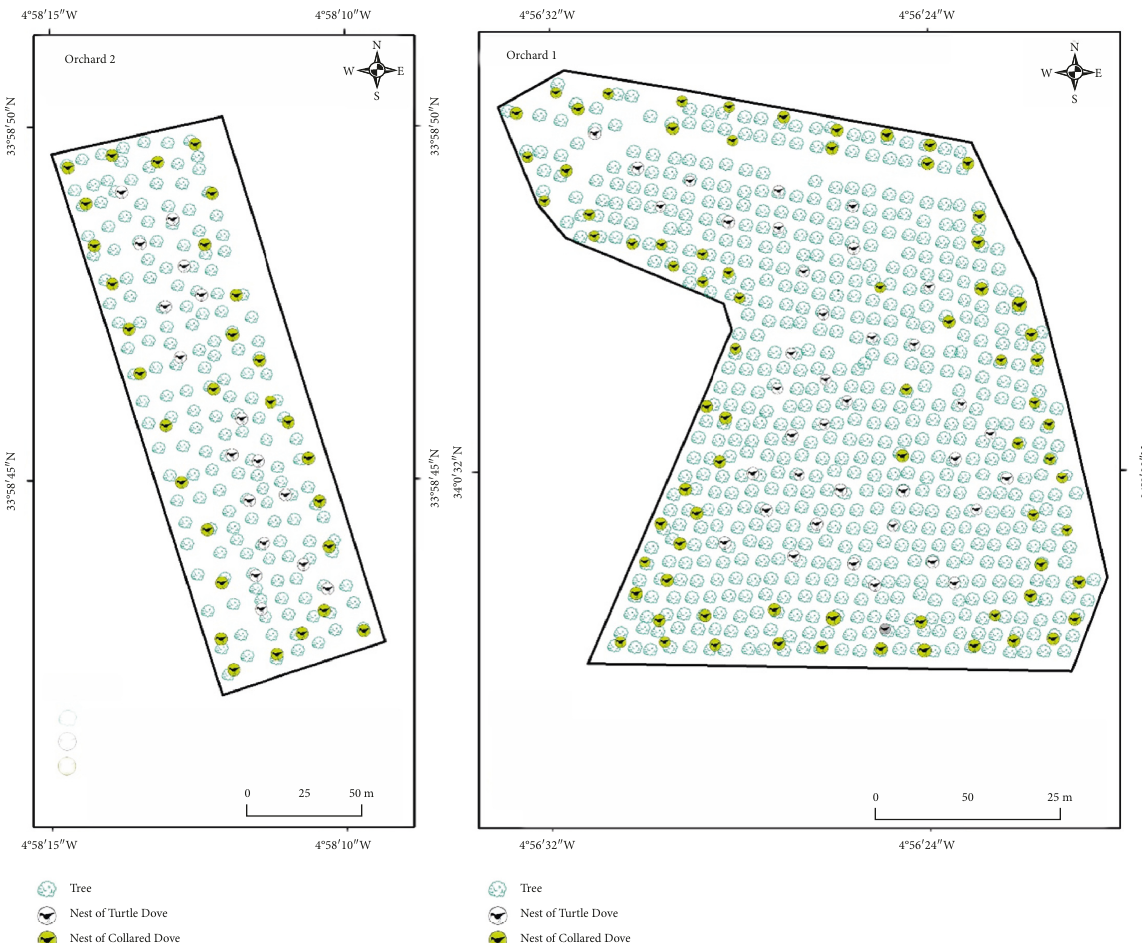
Figure 4: Map showing the nest location of turtle doves ( Streptopelia turtur arenicola ) and collared doves ( Streptopelia decaocto ) in olive